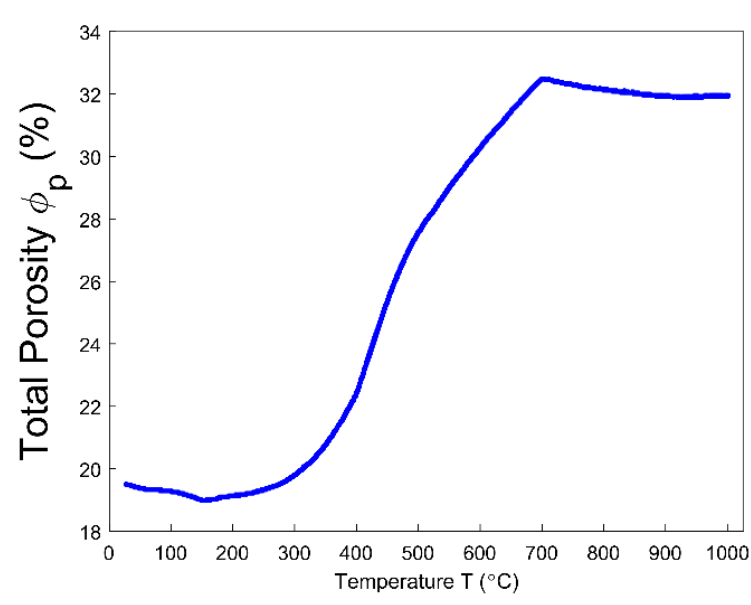
Figure 12. Total porosity.